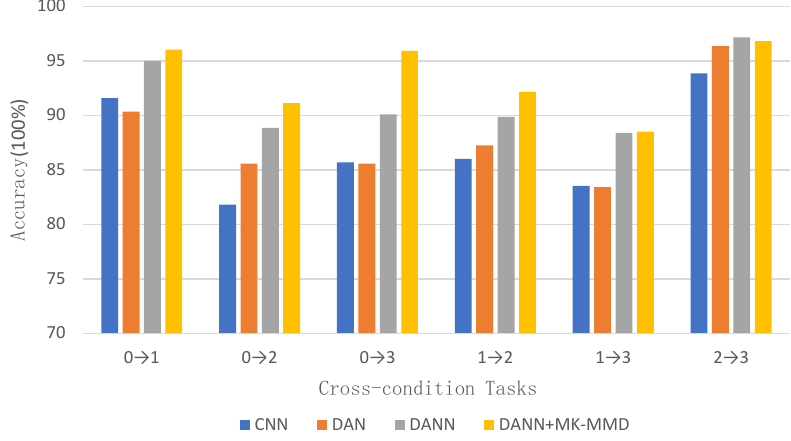
Figure 8. Classification accuracy of each method under cross-working